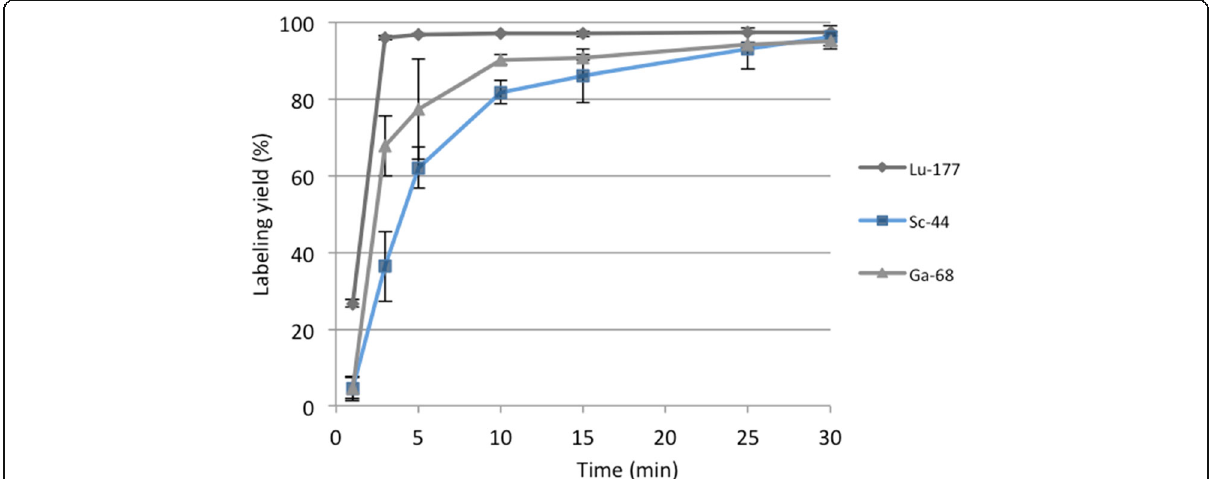
Fig. 6 Labeling yields for 31 with scandium-44, gallium-68, and lutetium-177 (20 nmol; 30 min; 95 °C; n = 3)